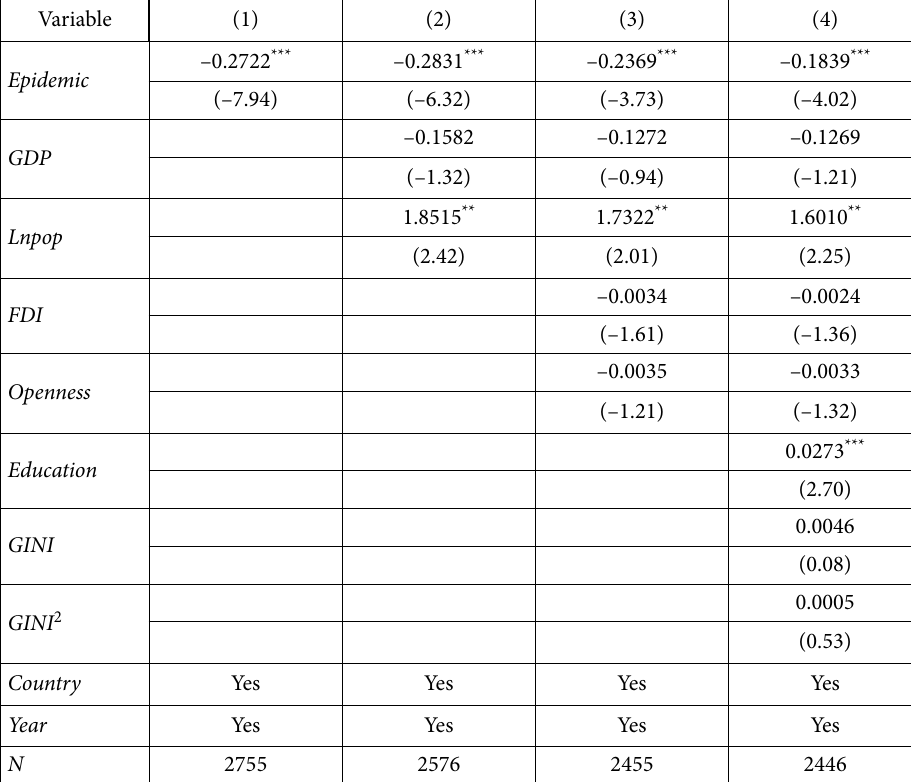
Table 2. Estimation results of the Panel Poisson